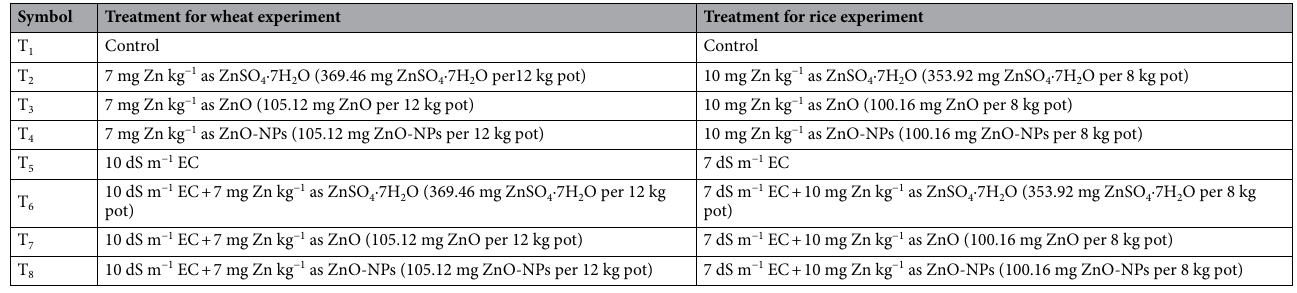
Table 2. Treatment